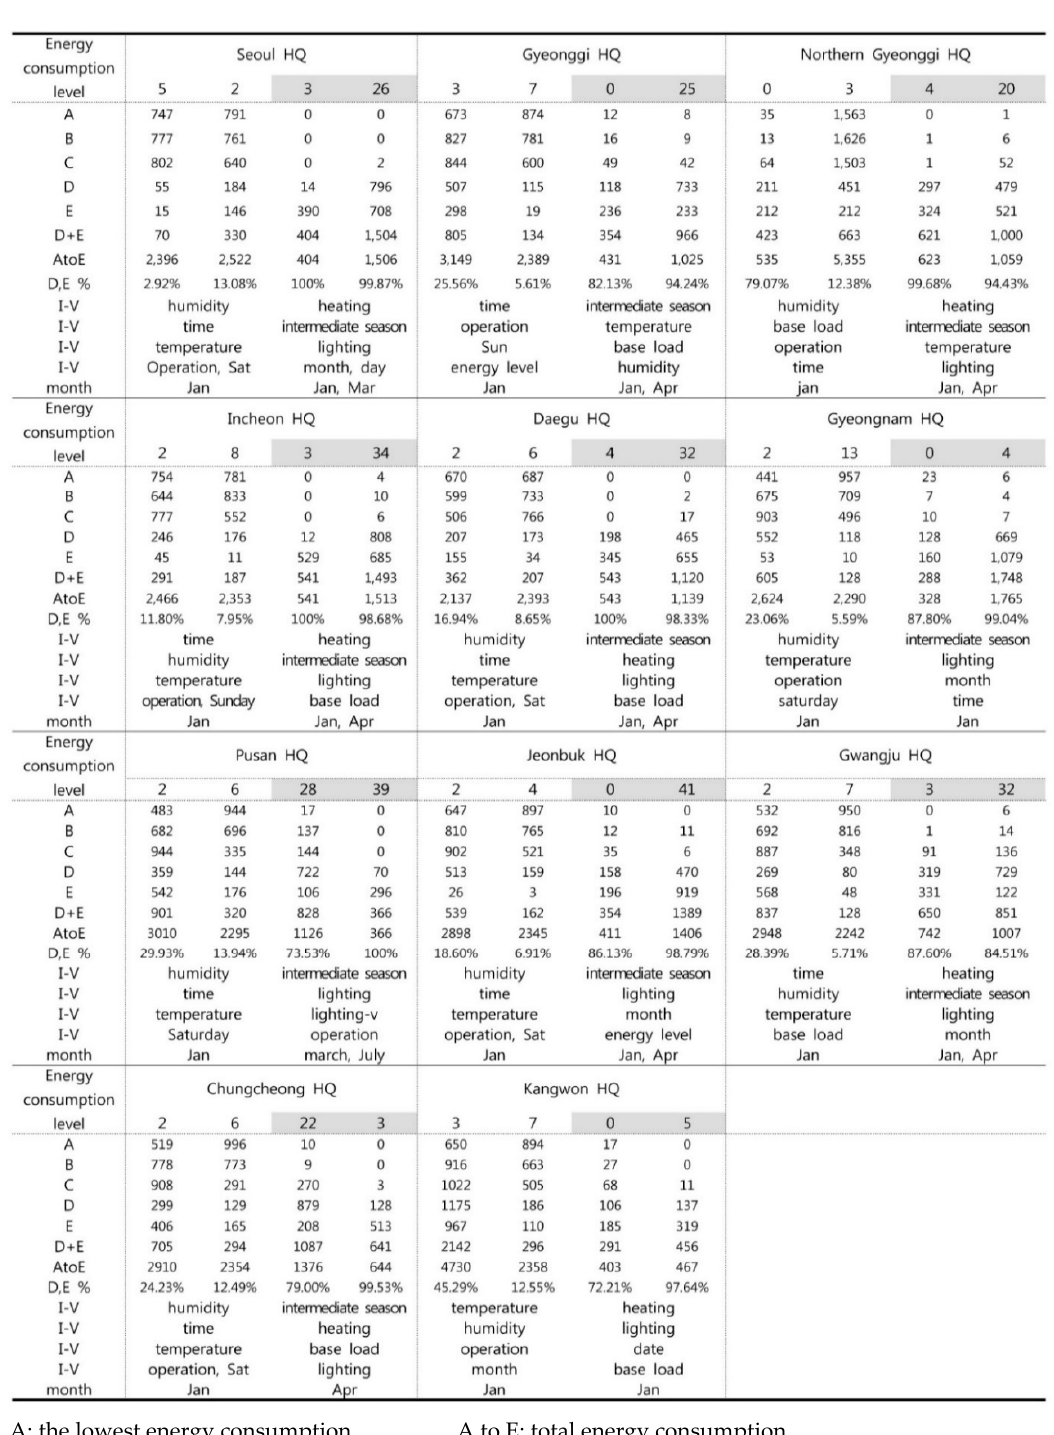
Figure 5. Result of the clustering of 11 buildings.